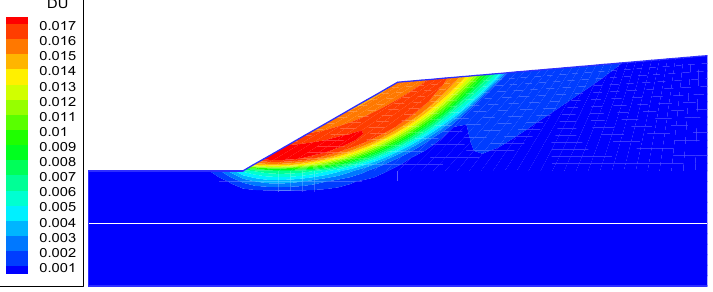
Figure 14. Contours of the displacement increment in Case 2.